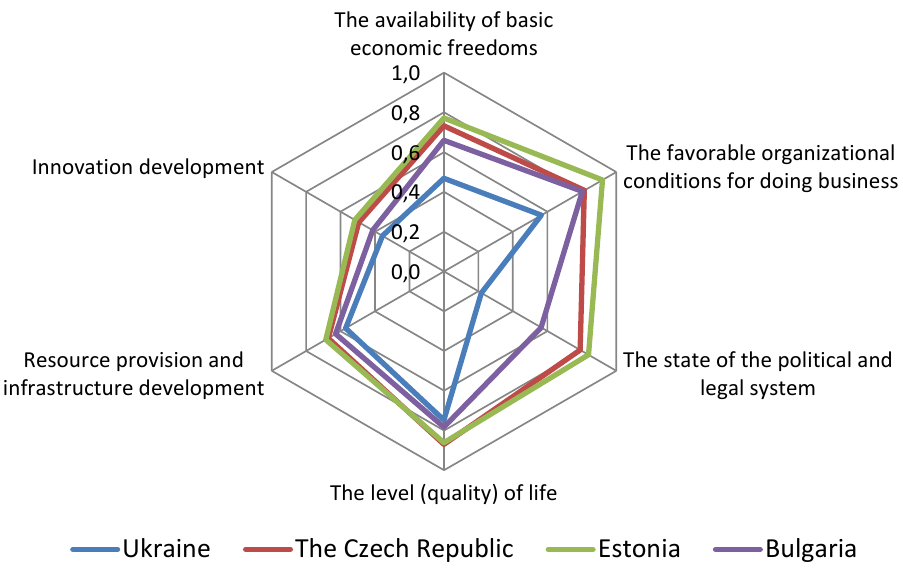
Figure 2. Business environment security in Ukraine and the countries-leaders of groups in